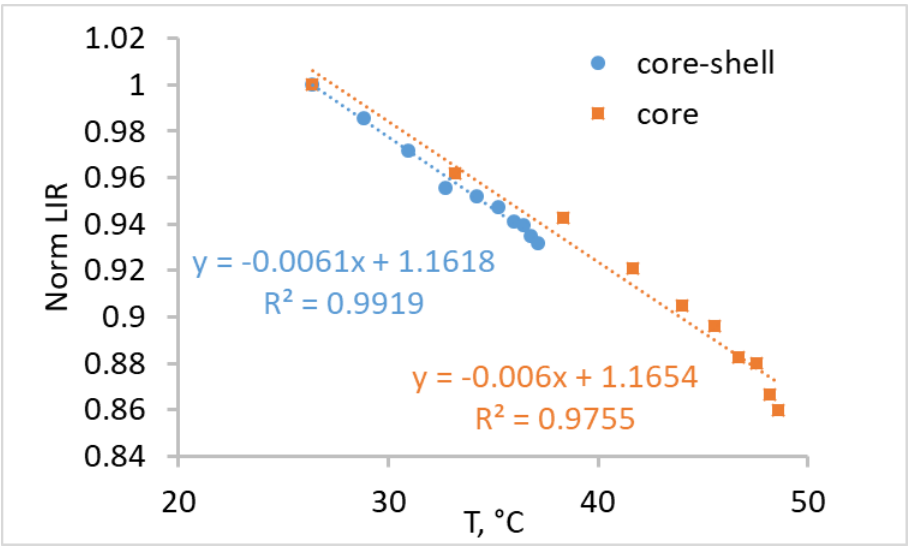
Figure 6. The dependence of luminescence intensity ratio (LIR) normalized to the value at 29 °C on the heating temperature for the core and core-shell nanoparticles in water.